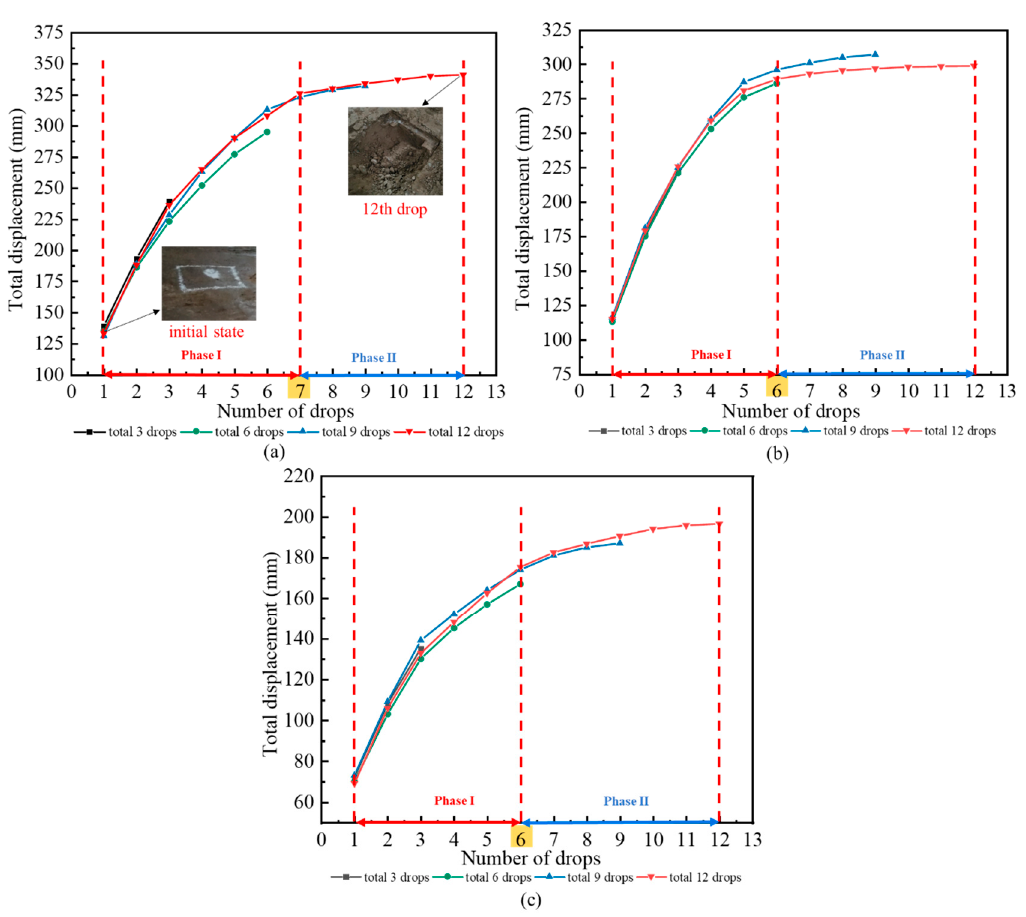
Figure 7. Total displacement of rammer under different conditions: ( a ) condition 1; ( b ) condition 2; ( c ) condition 3. ( c ) condition 3. Sensors 2020 , 20 , x